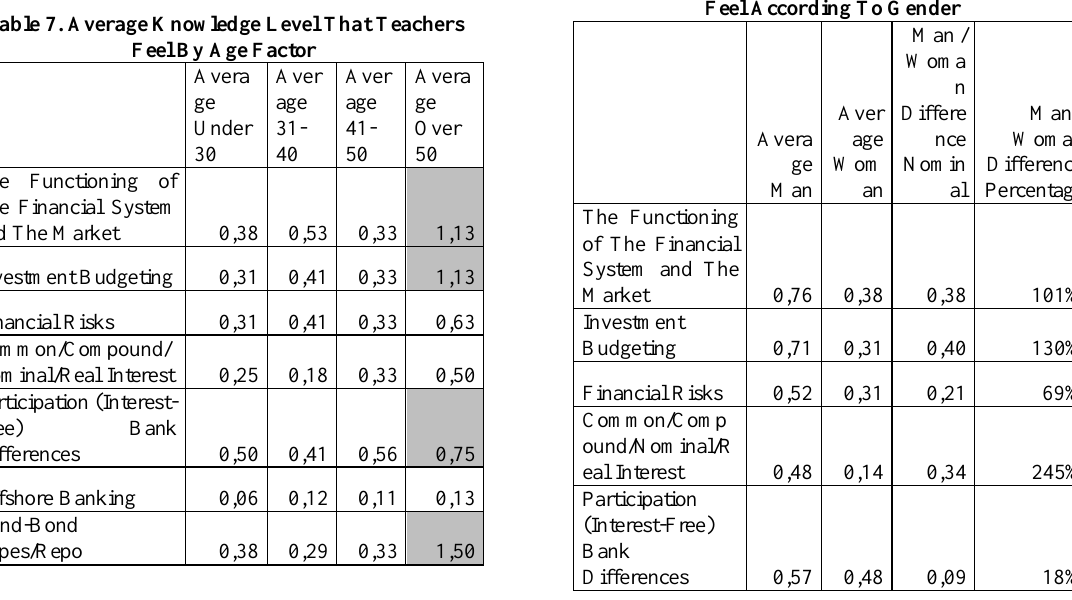
Table 8. Average Knowledge Level That